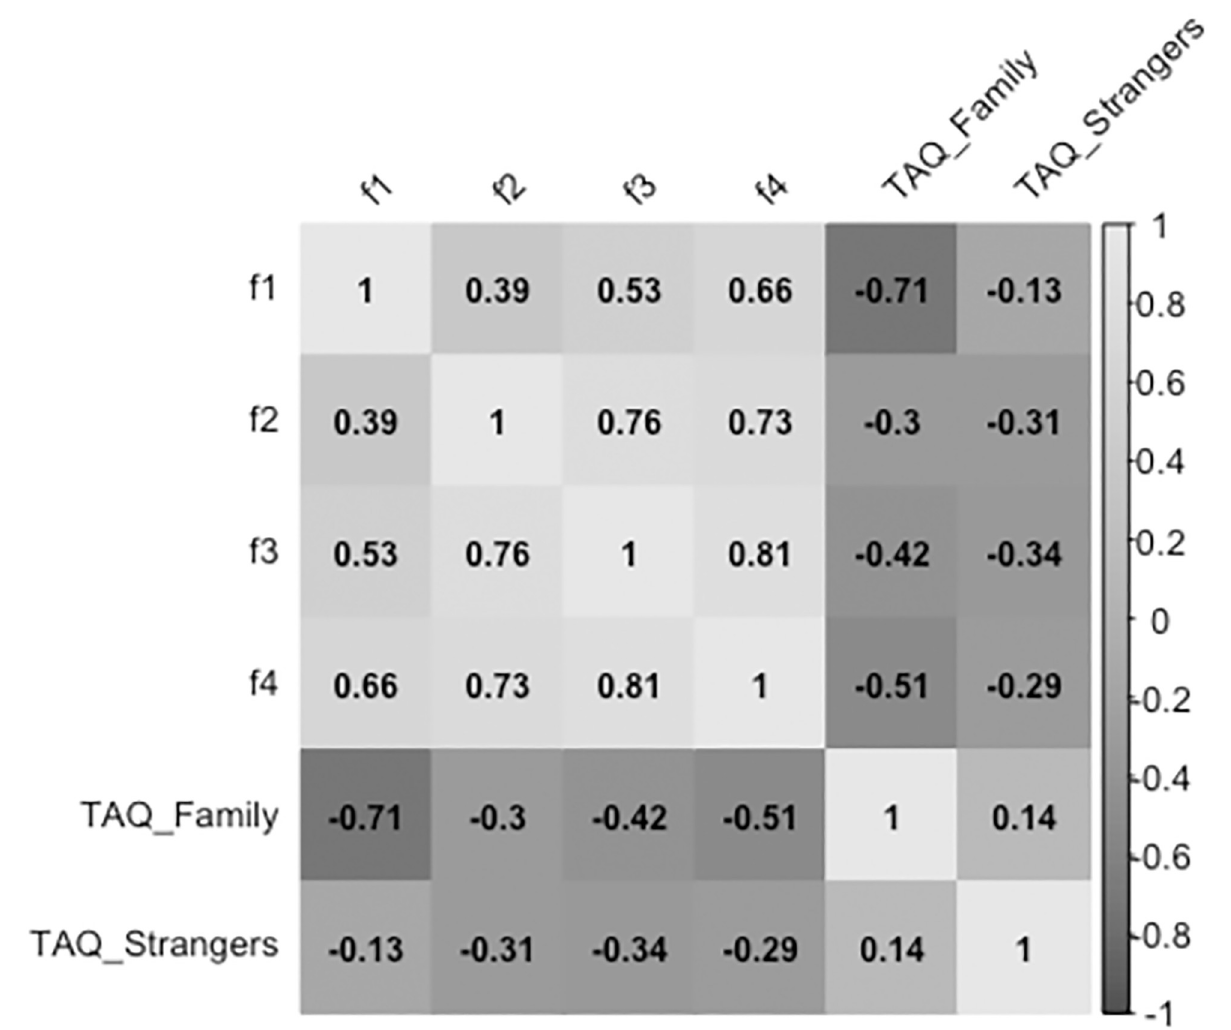
Fig 2. Bivariate correlation coefficients between family and stranger subscales of TAQ and factor scores of TBQ (n = 2040). Note. r, Pearson’s bivariate correlation coefficient and significance levels are reported; f1 = Childhood/Adolescent Touch Experience; f2 = Comfort with Interpersonal Touch; f3 = Fondness for Interpersonal Touch; f4 = Adult Touch